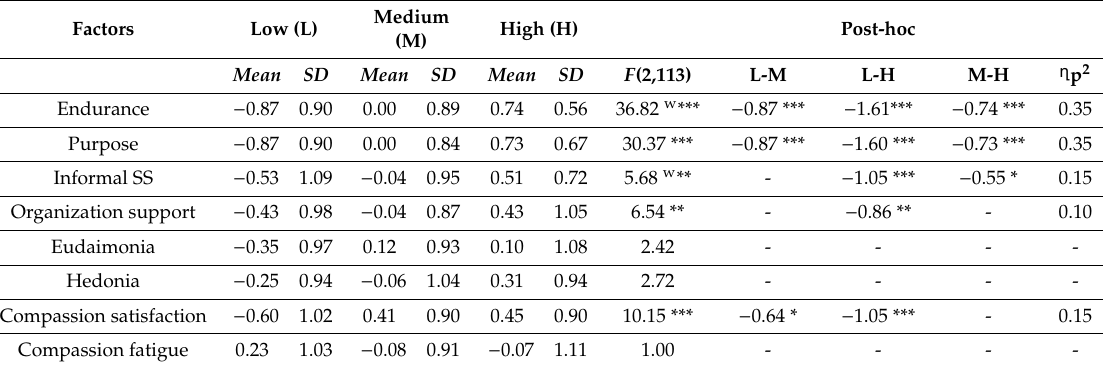
Table 3. ANOVA for contrasting volunteers with di ff erent levels of well-being.